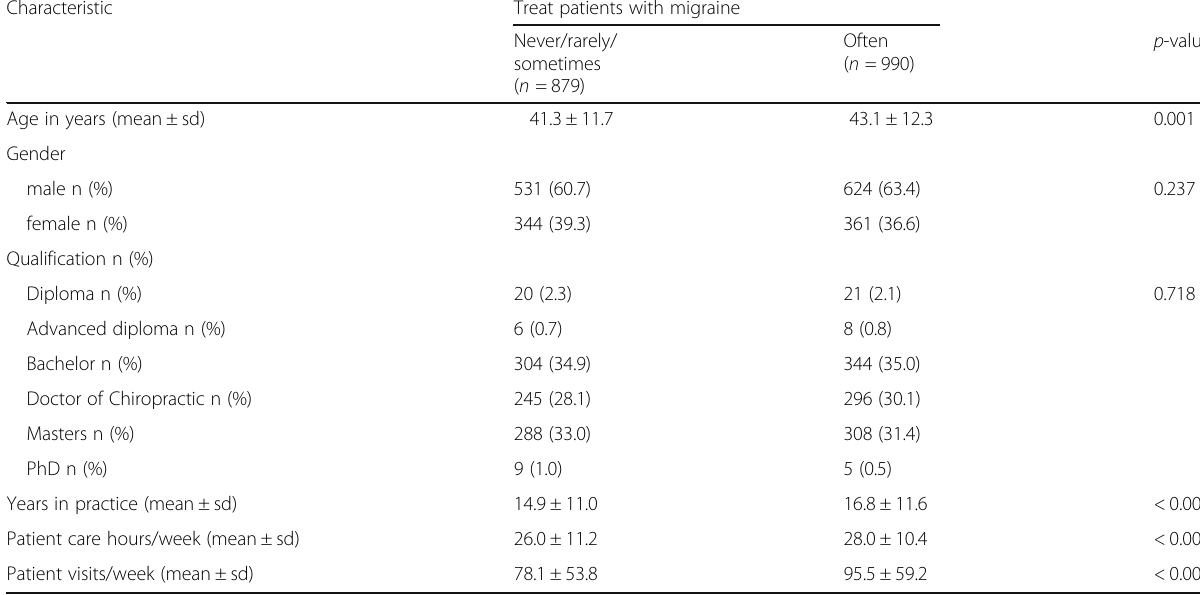
Table 1 Distribution of practitioner characteristics across frequency of practitioner treating patients with migraine